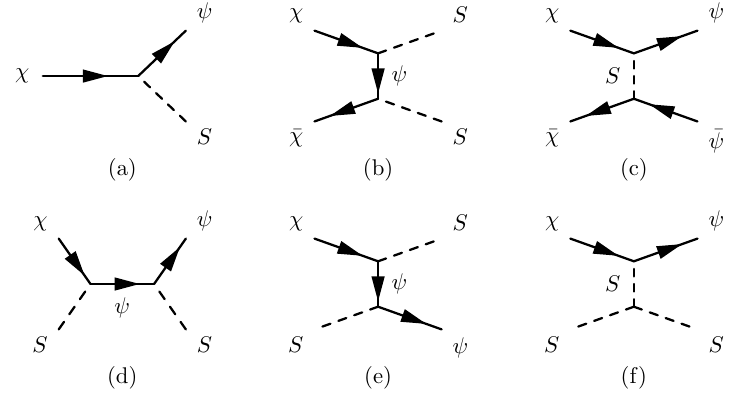
Figure 7 . Processes which may connect (cid:31) to the thermal bath. We do not show diagrams involving (cid:21) p , please see